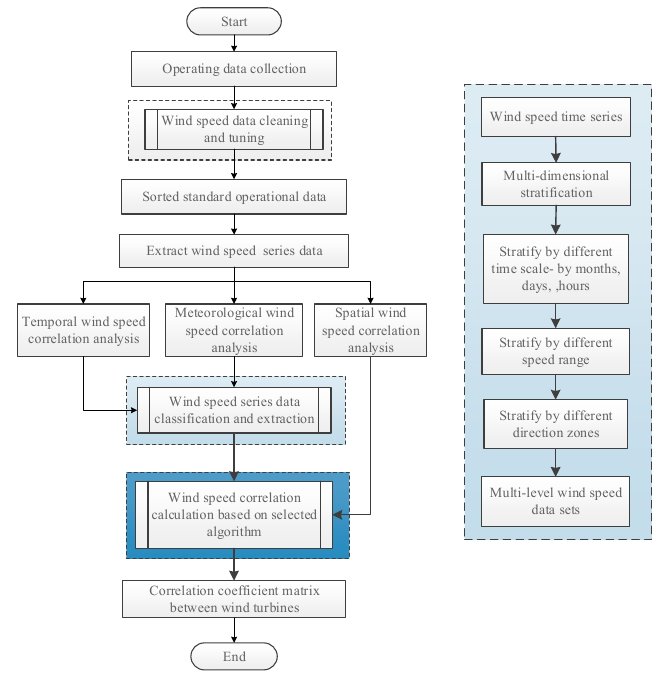
Figure 3. Calculation flow of wind speed correlation.